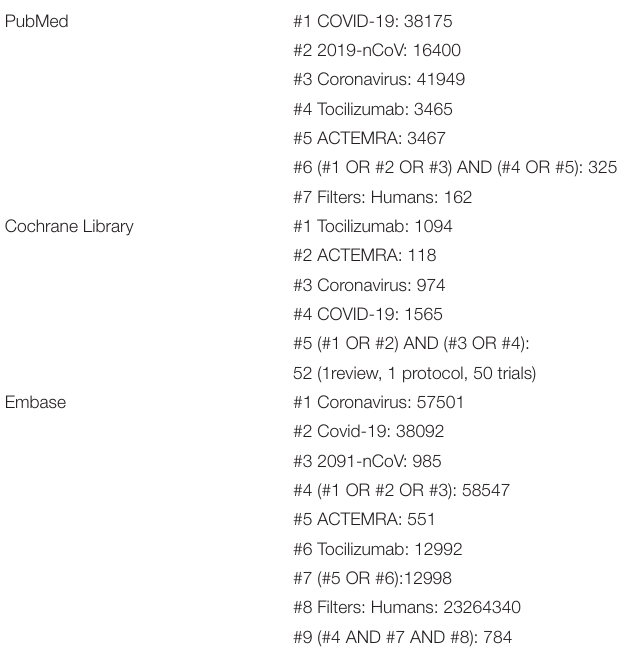
TABLE 1 | Search strategy in three databases until February 1,